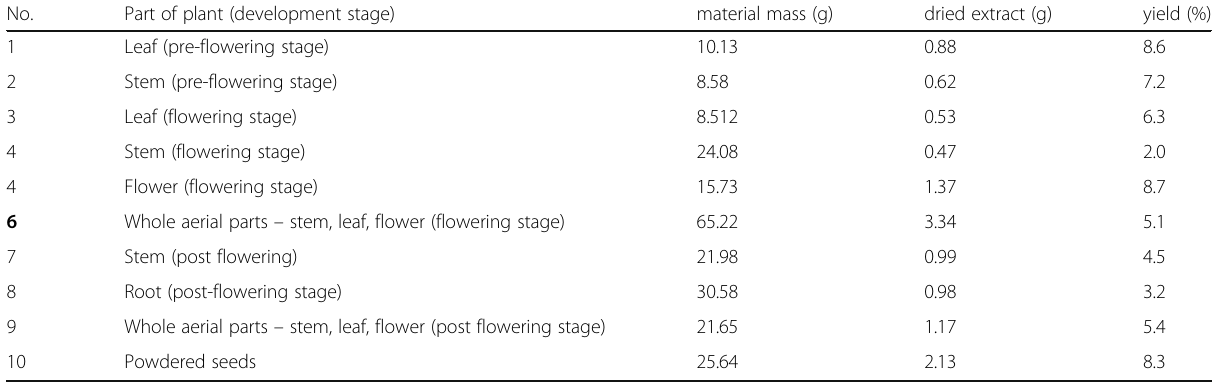
Table 1 Numbering of the extracts and yield (w:w) of